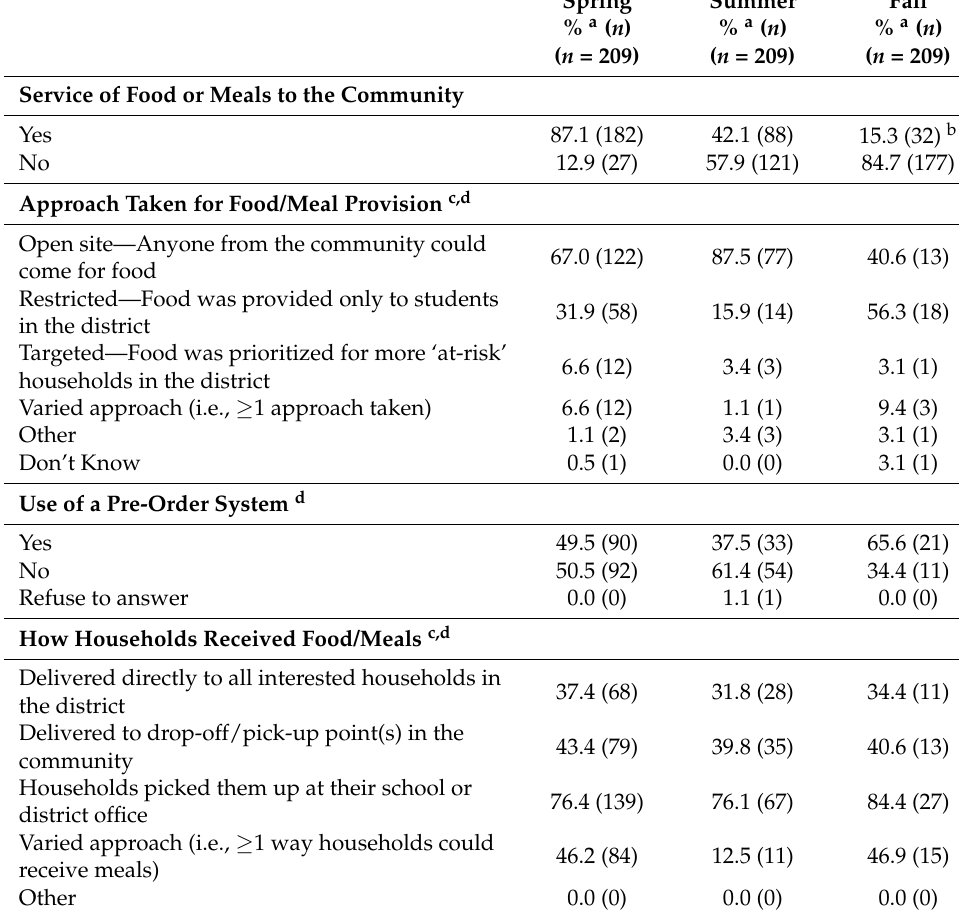
Table 2. Food/Meal Provision and Methods of Distribution across